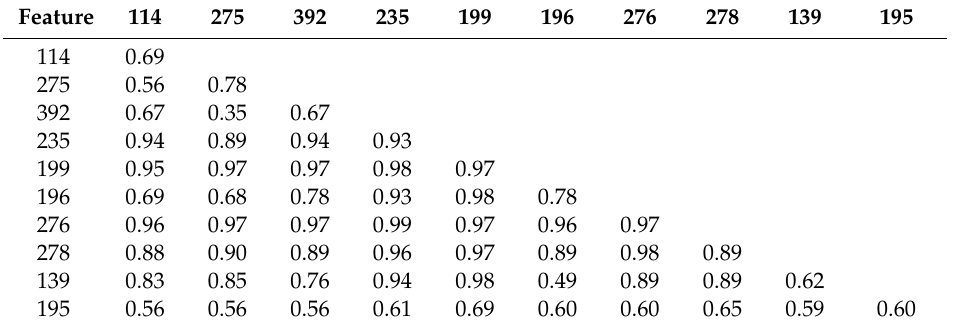
Table 10. E ff ect of selected features for level 4.